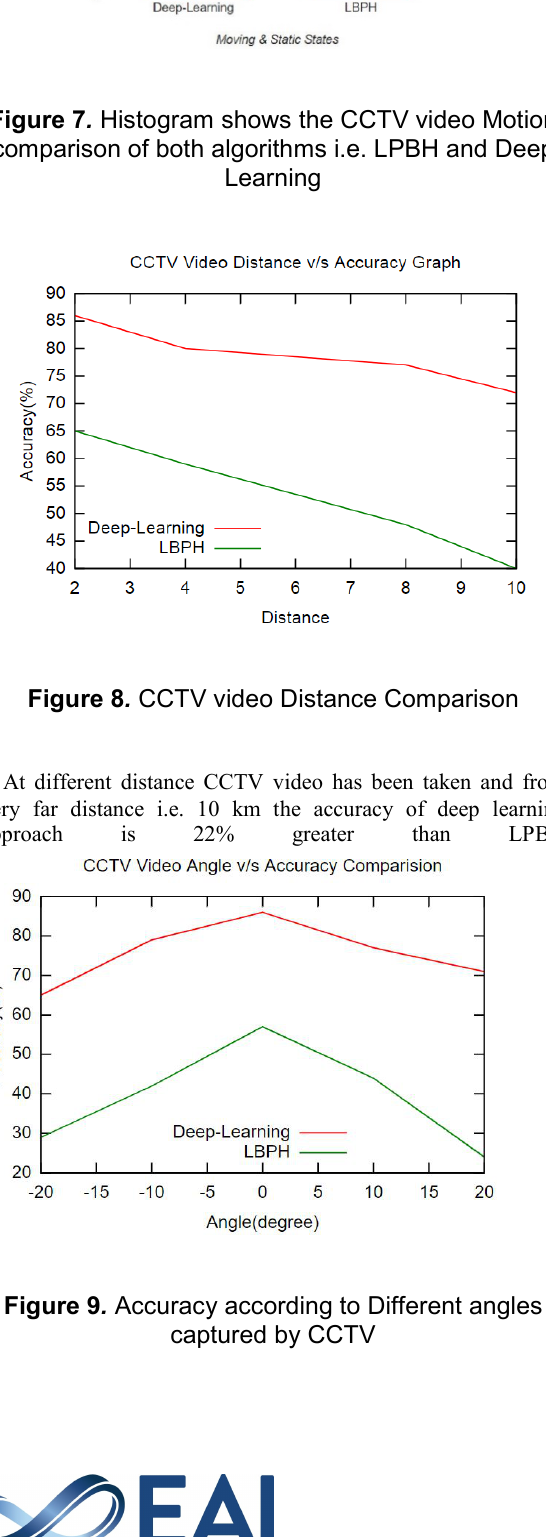
Figure 9 . Accuracy according to Different angles captured by CCTV